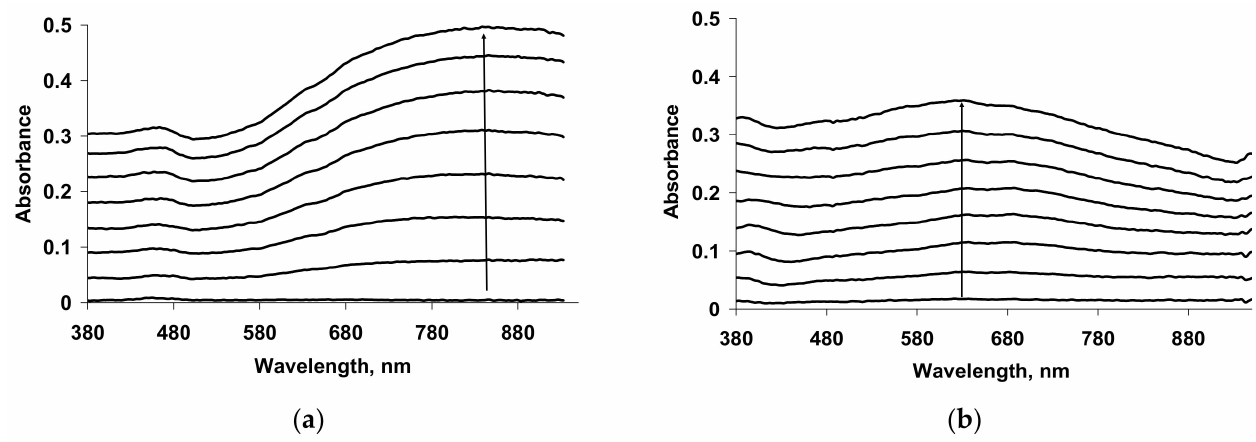
Figure 8. Evolution of UV–Vis–NIR absorption spectra of PPy films with time (increases in the direction of the arrows) in the course of electrosynthesis in GS-regime in the aqueous solutions of PSSA ( a ), i-PASA ( b ). Reprinted by permission from Springer Nature Customer Service Centre GmbH: Springer Nature, Journal of Solid State Electrochemistry, “Electrodeposition of thin films of polypyrrole-polyelectrolyte complexes and their ammonia-sensing properties”, O. L. Gribkova et al., Copyright 2020